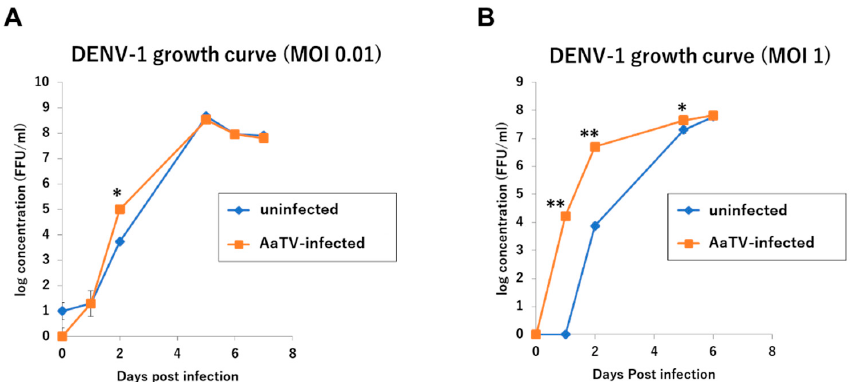
Figure 14 . Effect of AaTV infection in C6/36 cells on DENV growth. ( A ) DENV-1 growth curve [multiplicity of infection (MOI) = 0.01] ( B ) DENV-1 growth curve (MOI = 1). Controls were DENV infection on naïve C6/36 cells. Statistical significance was done by the t-test * = p ≤ 0.05, ** = p ≤ 0.01 .